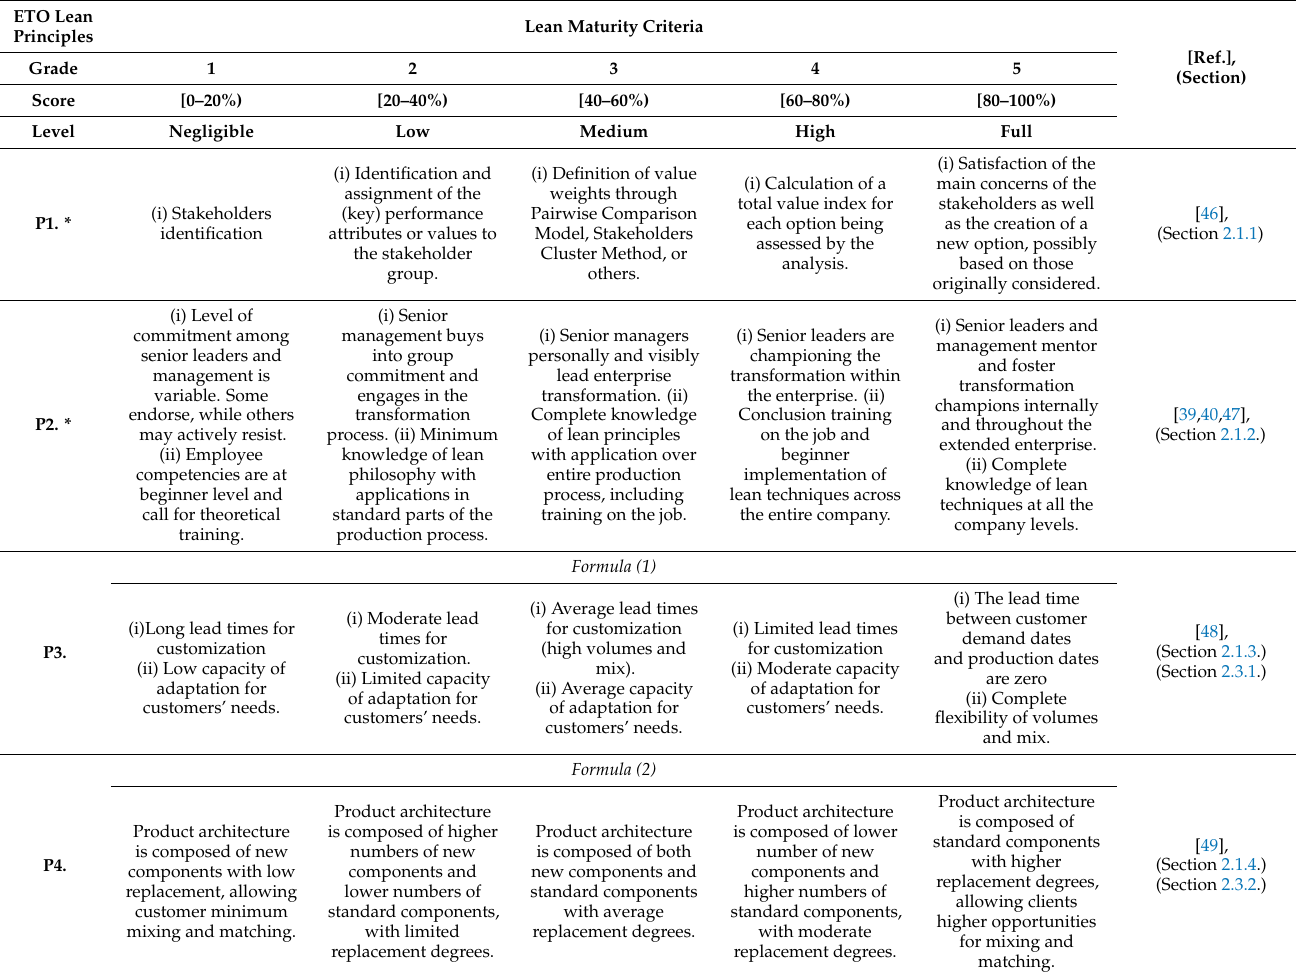
Table 2. The ETO lean assessment 10 × 5 matrix. For each principle, the lean maturity level, grade, and score range (percentage) are compared in the table header. The criteria and mathematical formulas are derived from the definitions in Sections 2.1 and 2.2, respectively, according to the references, and are presented in the sections indicated in the last column. The principles labeled with (*) denote a lack of a mathematical